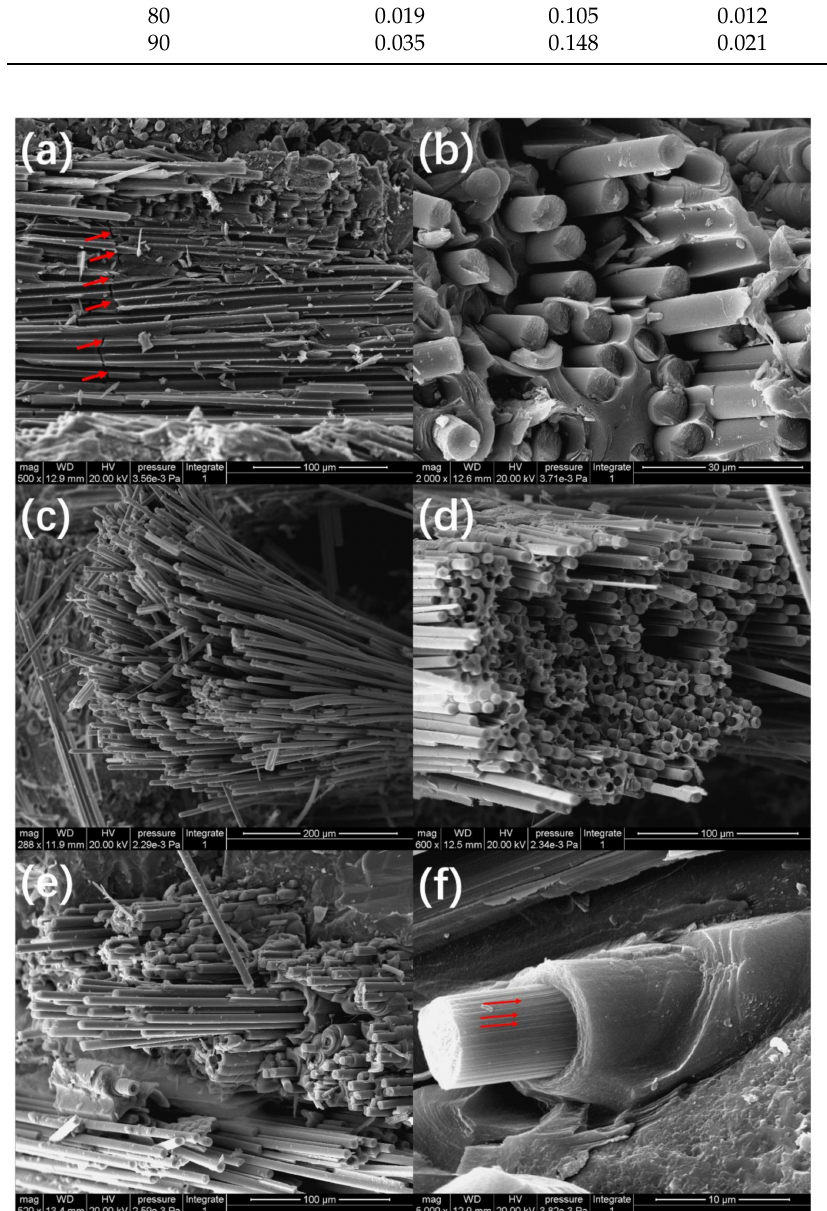
Figure 13. ( a ) Matrix cracking; ( b ) fibers pull out from the twill woven ply; ( c ) fibers pull out from the [45 ◦ ] ply; ( d ) fibers pull out from the [ − 45 ◦ ] ply; ( e ) fibers pull out from the [ ± 45 ◦ ] plies; and ( f ) the single pulled out